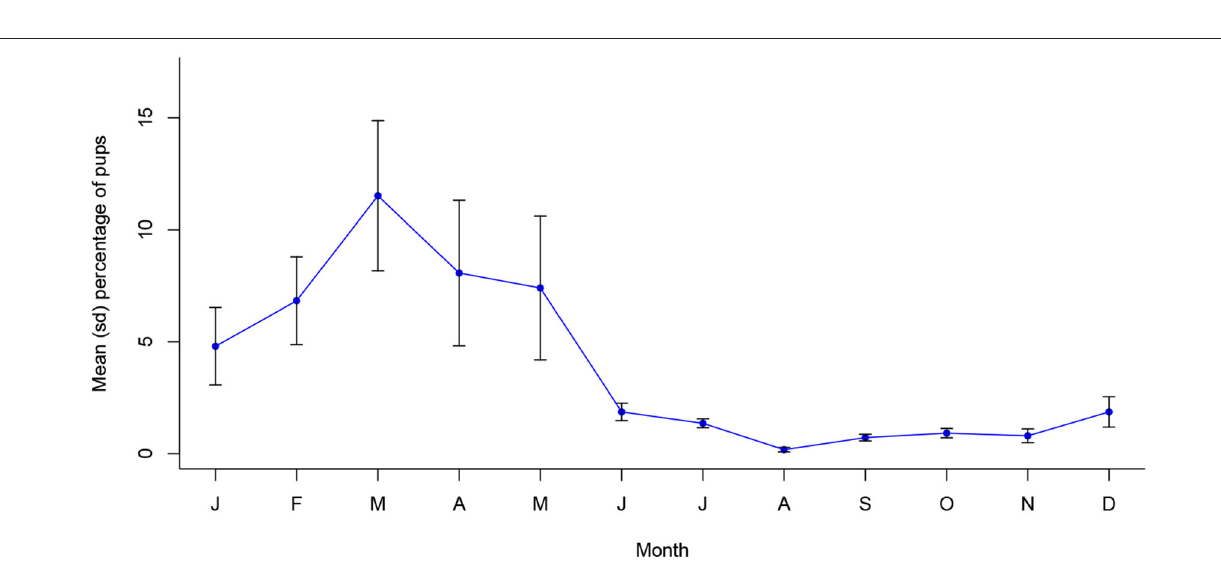
Frontiers in Veterinary Science |